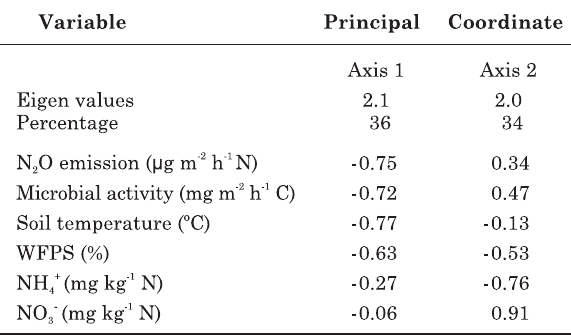
Table 1. Correlation coefficients between the variables evaluated in a subtropical Oxisol in autumn (May 7 to 30, 2007), in Southern Brazil and the ordination axes obtained in the Principal Coordinate